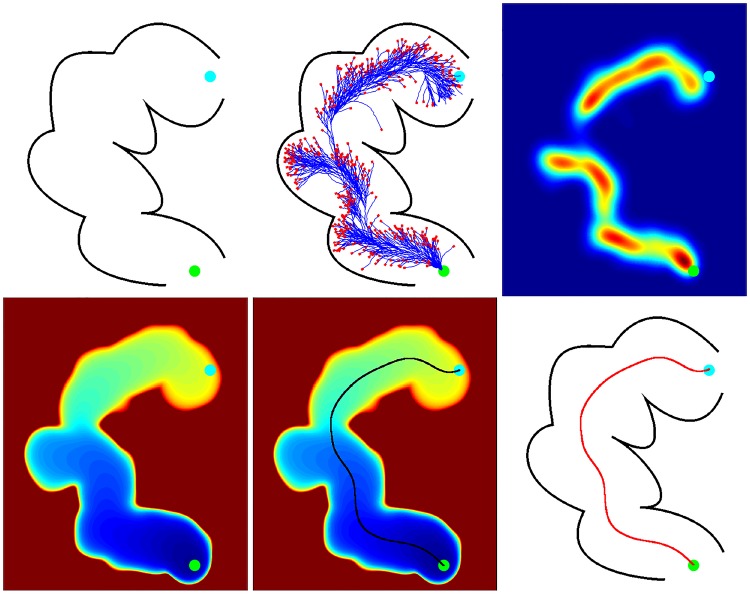
An overview of the particle filtering method.Top row shows: a segment of colon with particle filter start and end points in green and cyan respectively (left); execution of a simplified version of the particle filtering method showing ‘live’ and ‘terminated’ particles in blue and red respectively (middle); the speed function calculated from the weighted sum of Gaussians of particle positions (right). Bottom row shows: the geodesic distances from the start point, calculated by fast marching (left); the centreline path found by computing the shortest geodesic distance from start to end point (middle); the centreline path overlay on the original image (right).